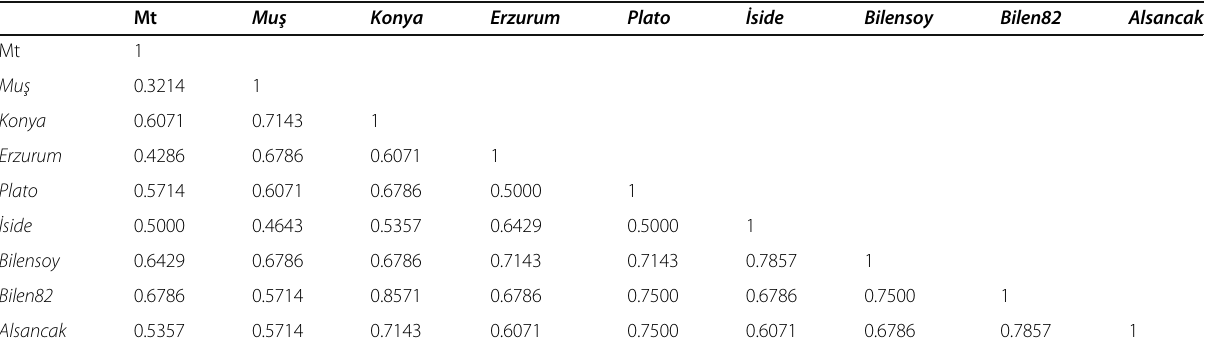
Table 3 Genetic similarity for 9 varieties of alfalfa